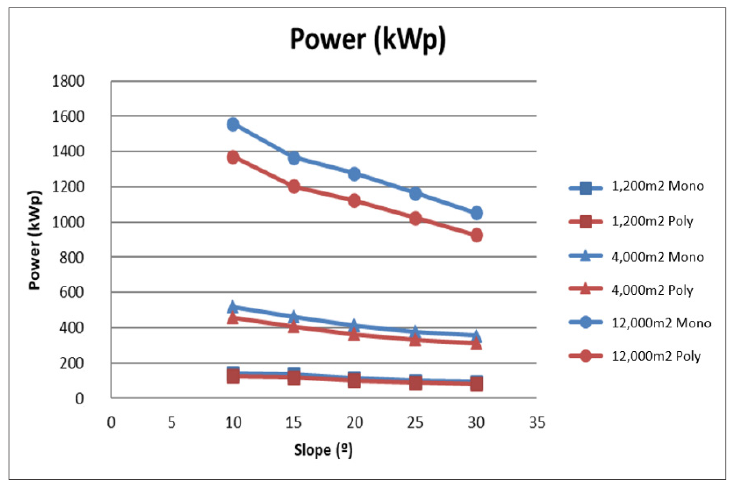
Figure 4. Installed power as a function of module inclination and surface available.